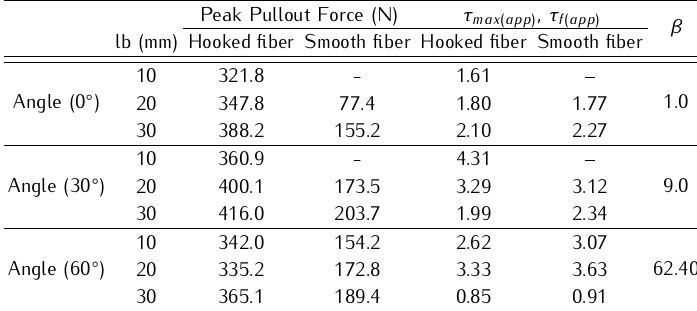
Table 8. Proposed values of τ max ( app ) , τ f ( app ) , β and the corresponding P max obtained through comparison of the Cunha [29] experimental results with respect to the inclination of